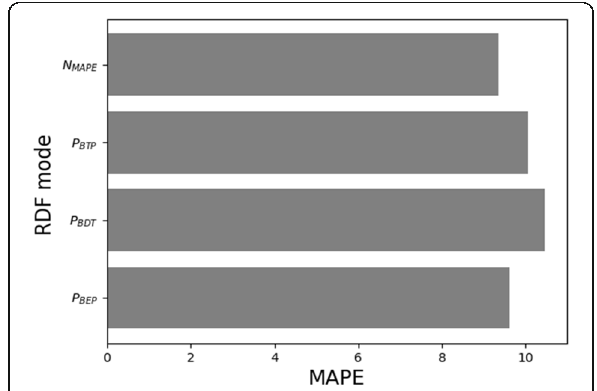
FIG. 9 MAPE of N-mode and P-mode models FIG. 10 MAE of N-mode and P-mode